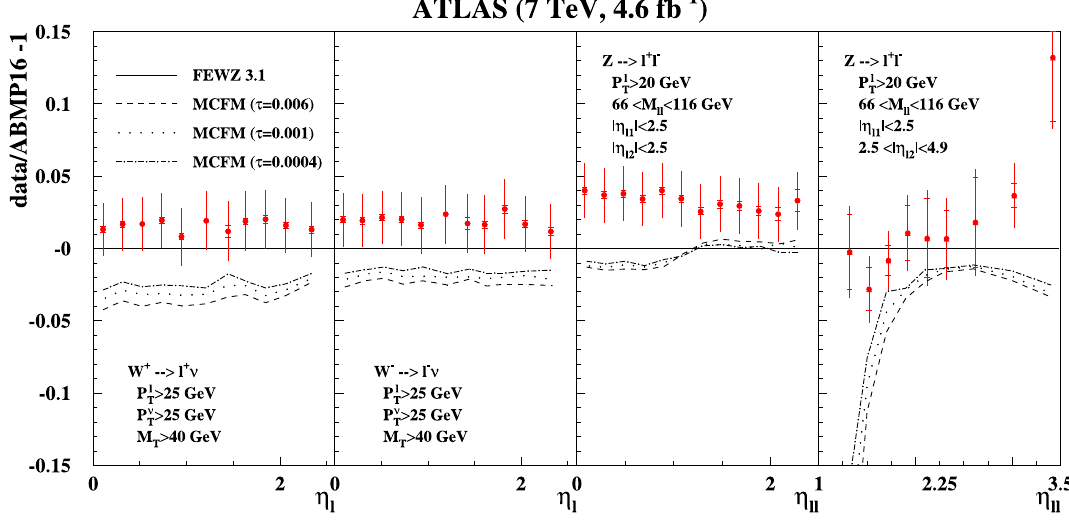
Fig. 7 Same as Fig. 5 using predictions by the MCFM code and with different values for the jettiness slicing parameter: τ cut = 6 · 10 − 3 (dashed), τ